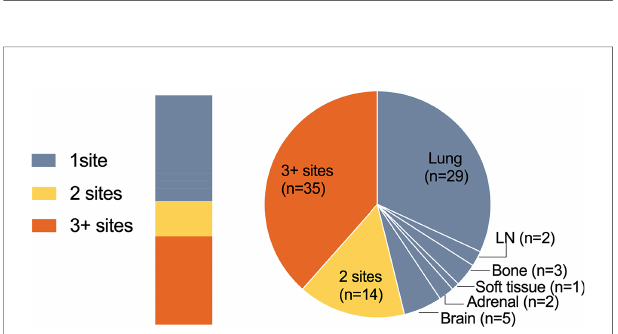
FIGURE 4 | Numbers of progression sites. Pie chart showing the number of patients with one site (gray), two sites (yellow), or three or more sites (orange) of progressive